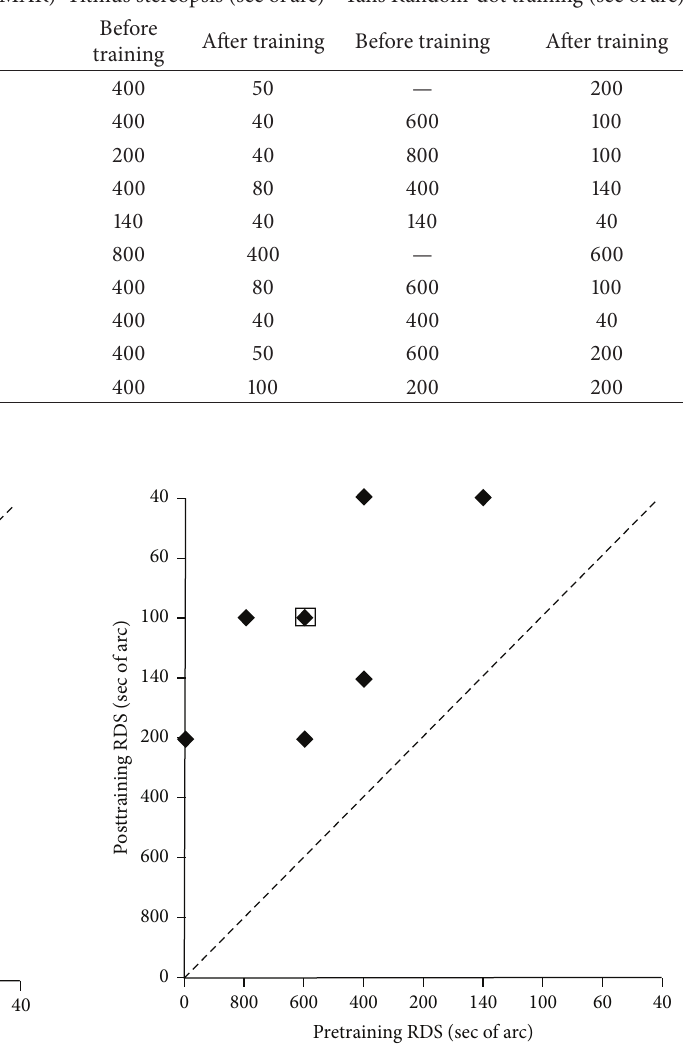
Figure 4: Random-dot stereogram data before and after the training. The x -axis represents the RDS of the subjects before the treatment and the y -axis represents the RDS of the subjects after the treatment. Stereopsis of Random-dot stereogram was statistically significantly improved ( 𝑃 = 0.018 ). RDS: Random-dot stereograph. A square outline represents two overlapping data